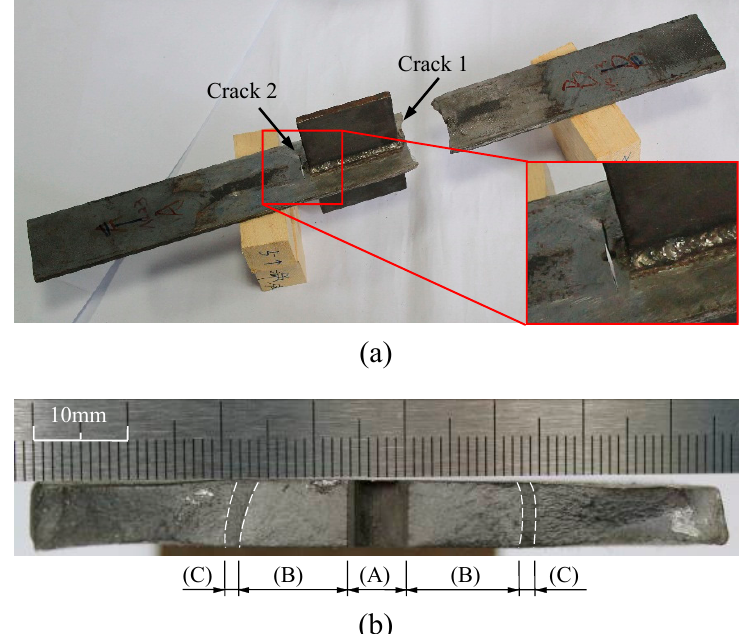
Figure 4. ( a ) Failed specimen U-2; ( b ) Fracture surface of specimen U-2 (area A: artificial notch; area B: crack propagation due to the original cyclic loading; area C: crack propagation due to the inserted cyclic loading).